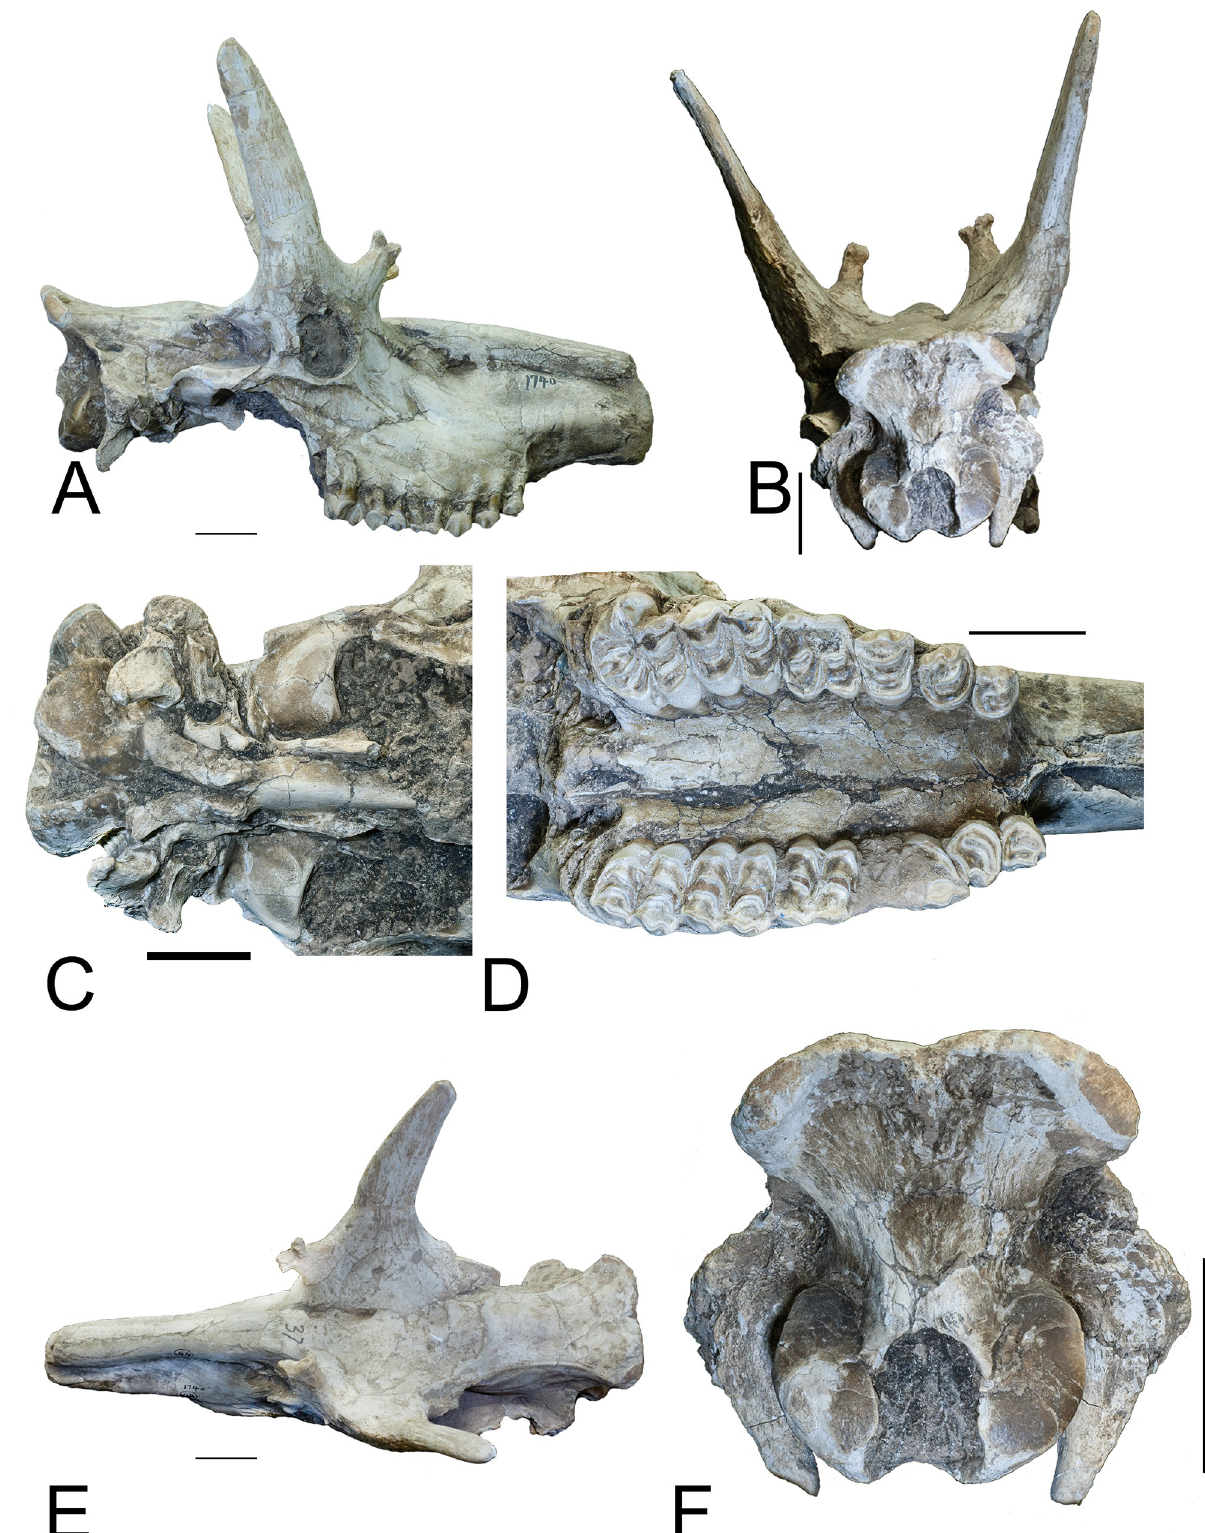
Fig 1. Schansitherium tafeli skull HMV 1740. (A) Right lateral aspect. (B) Occipital view. (C) The ventral braincase. (D) Palatal view of dentition (right M3 is abnormal). (E) Dorsal view. (F) Close view of occiput. Scale 50mm. https://doi.org/10.1371/journal.pone.0211797.g001 PLOS ONE | https://doi.org/10.1371/journal.pone.0211797 February 12,